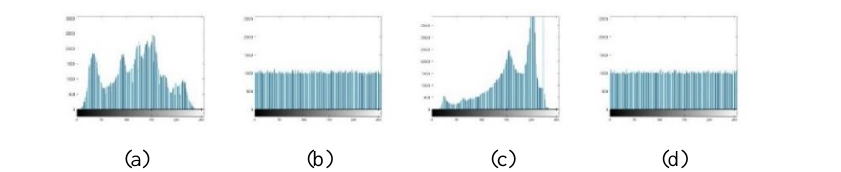
Fig. 3. Lena (a) Plain image. (b) Encrypted image. House (c) Plain image. (d) Encrypted image.